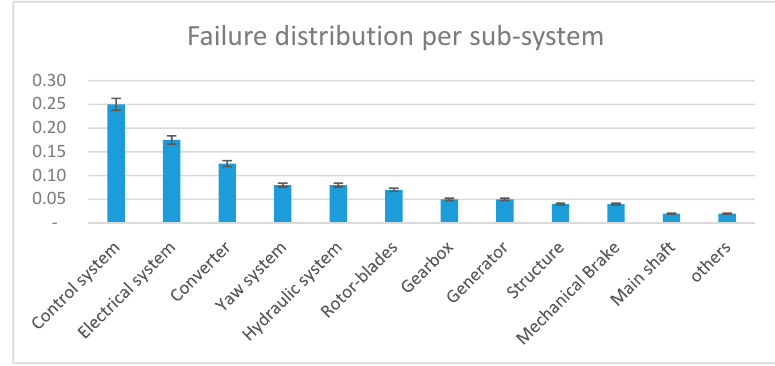
Figure 3. Failure distribution per sub-system.